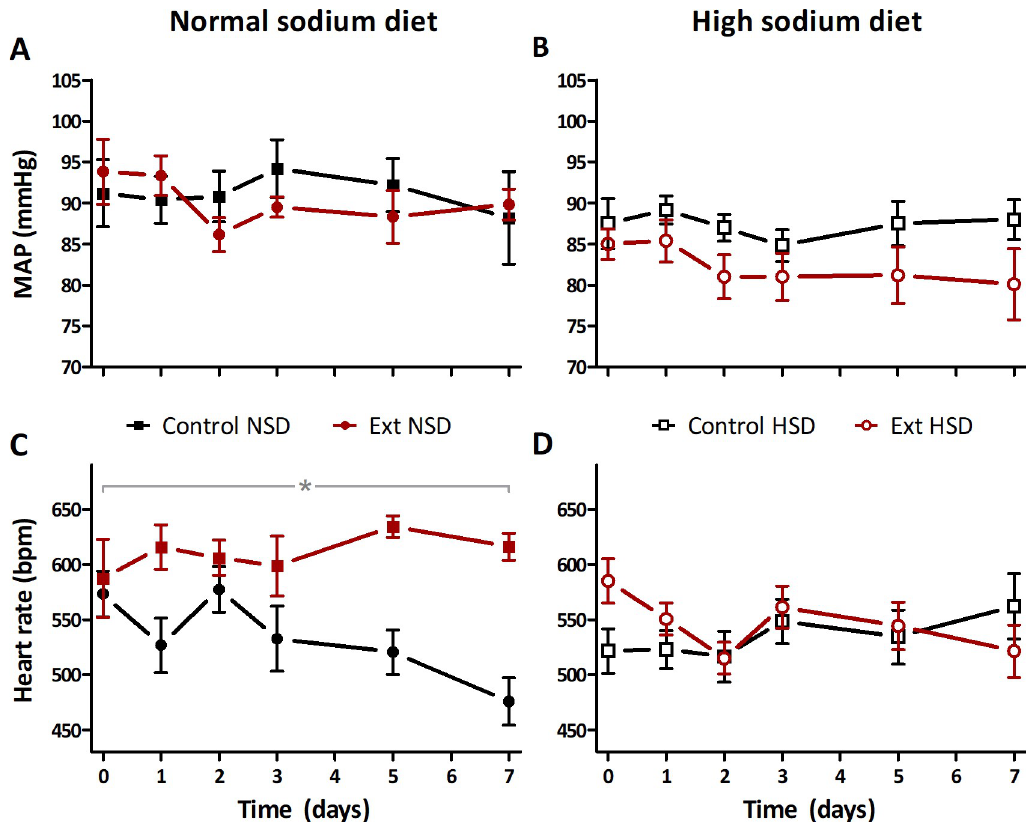
± 2 mmHg, n = 5) mice had a comparable tail-cuff MAP on a NSD (p = 0.76). (B) Ext1 +/- Ext2 +/- (82 ± 2.0 mmHg, n = 10) and control mice (87 ± 3 mmHg, n = 6, p = 0.15) had an equal MAP on a HSD. (C) On a NSD, heart rate was significantly higher in Ext1 +/- Ext2 +/- mice than in controls (610 ± 8 bpm vs. 534 ± 8 bpm, p < 0.001). (D) Heart rate was comparable in Ext1 +/- Ext2 +/- and control mice on a HSD (546 ± 11 bpm vs. 534 ± 14 bpm, p = 0.51). � p < 0.001. bpm, beats per minute; Ext, Ext1 +/- Ext2 +/- ; HSD, high sodium diet; MAP, mean arterial pressure; NSD, normal sodium